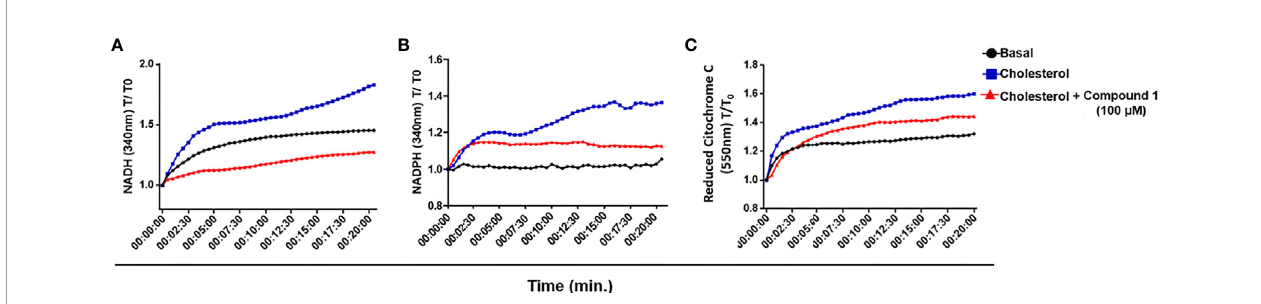
FIGURE 4 | M. leprae 3 b -HSD is a source of reductive power. (A, B) NAD + and NADP + reduction to NADH and NADPH, respectively, by 3 b -HSD activity was measured in a temporal kinetic curve every 30 s for 20 min at 340 nm. (C) Cytochrome C reduction was determined measuring the reduced form of Cytochrome C at 550 nm every 30 s for 20 min. In all conditions M. leprae WCL was incubated with 200 µM cholesterol, alone (blue) or in the presence of 100 µM compound 1 (red). A condition without cholesterol addition was also included as a control of basal levels (black). Representative of 3 independent experiments.